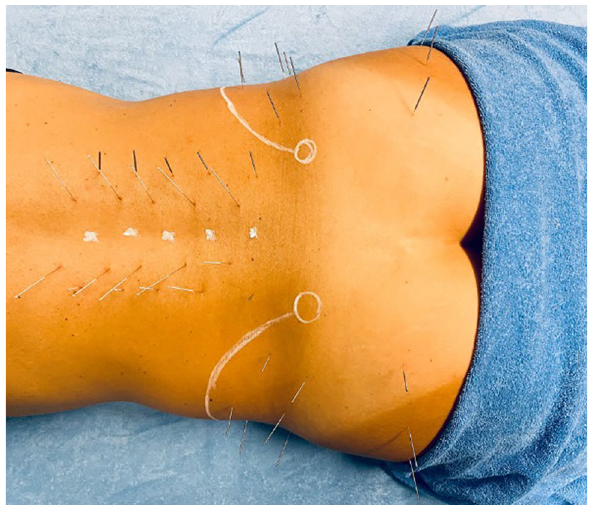
Figure 6. DN application in the experimental group. In the figure, as topographic reference points, the sites of the spinous processes of the vertebrae, the outlines of the iliac crests, and the posterior superior iliac spines are sketched in